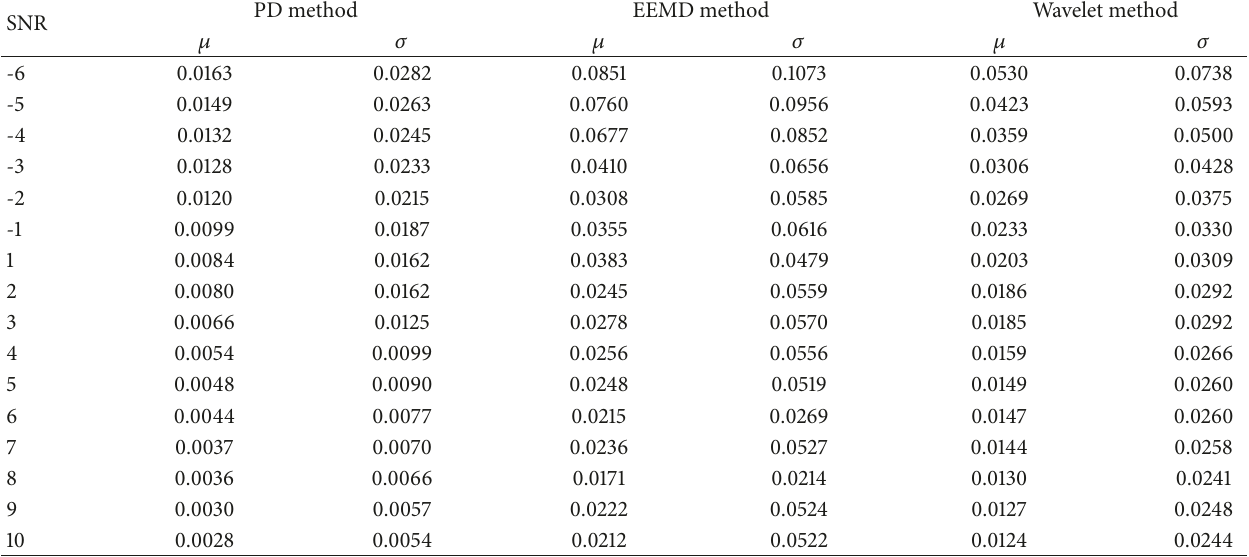
Table 2: Comparison of signal denoising indicator with different SNR.